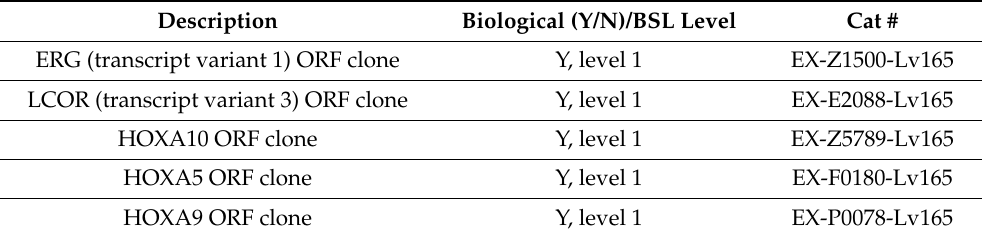
Table 1. Transcription Factor